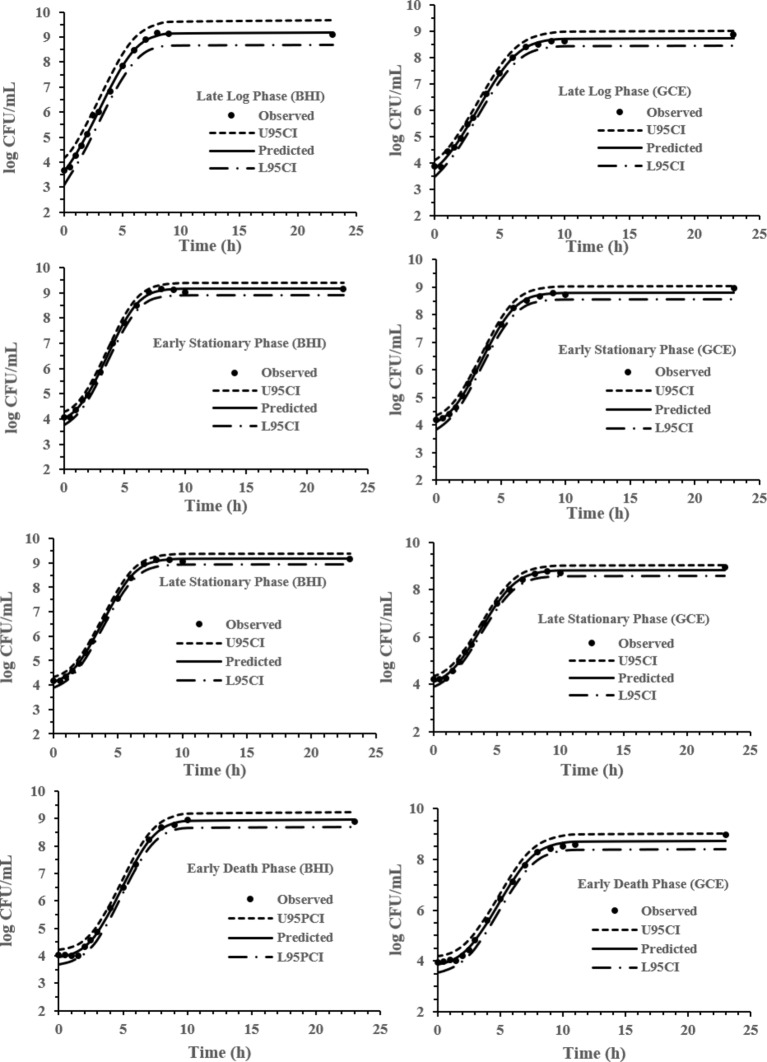
Baranyi model for S. Typhimurium DT104 in brain heart infusion broth (BHI) and ground chicken extract (GCE) at 37°C. Observed, predicted, upper 95% confidence interval (U95CI), and lower 95% confidence interval (L95CI).